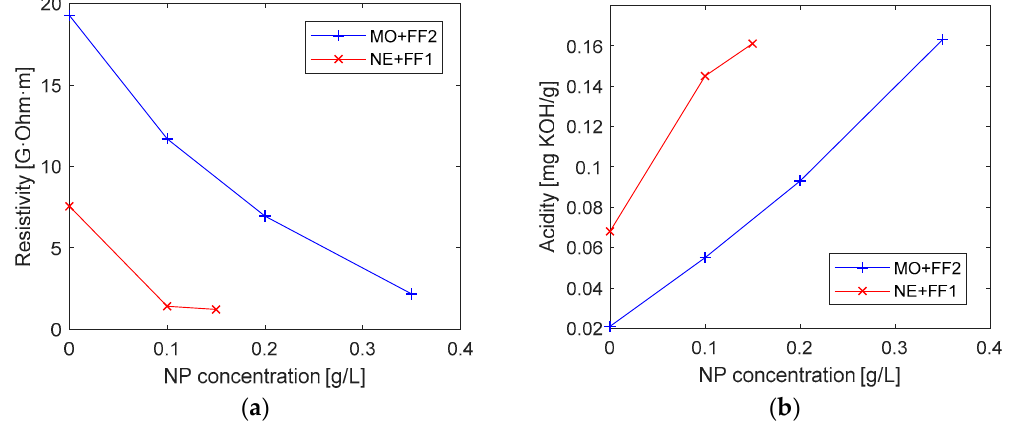
Figure 6. ( a ) Resistivity and ( b ) Acidity of the prepared DNF.